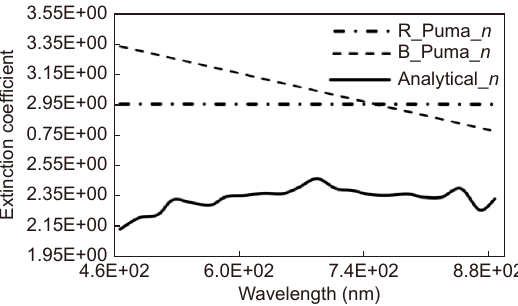
Fig. 7 | PUMA model validation with analytical refractive index ( n ); R_Puma: Simulation results when only reflectance was in- put; B_Puma: Simulation results when both reflectance and transmittance were inputs.